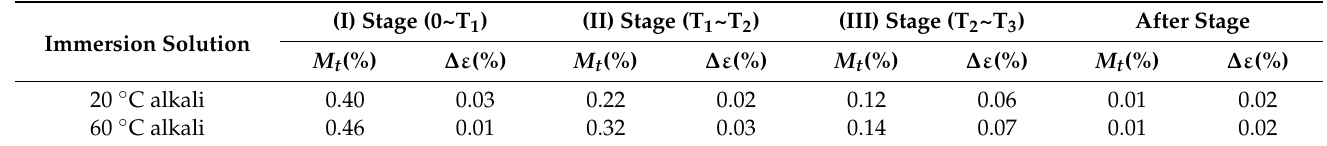
Table 3. Strain of epoxy resin samples immersed in the alkali solution at different temperatures. Immersion